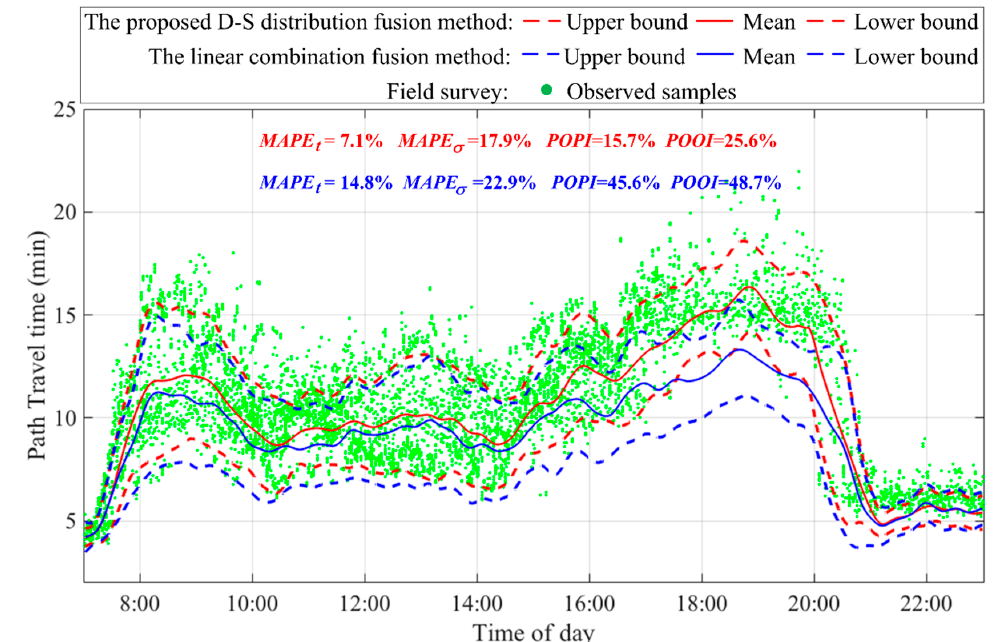
Figure 9. Path travel times of different methods during the period of interest.